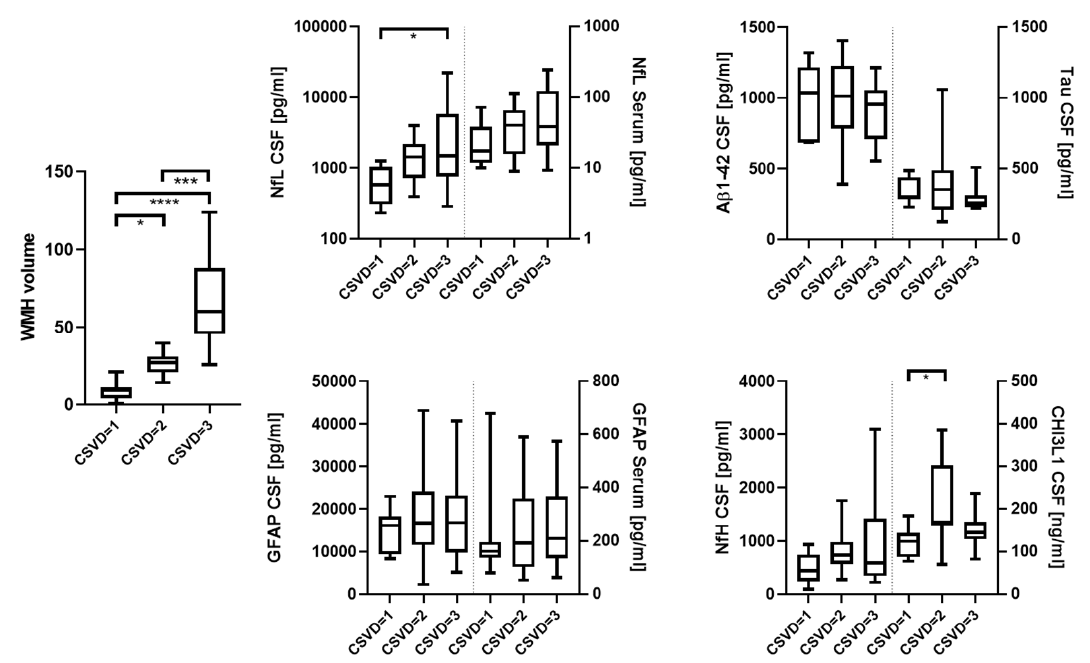
Figure 2. Degree of CSVD based on Fazekas (mild, moderate and severe) compared to WMH, NfL (CSF and serum), GFAP (CSF and serum), A β 1-42 (CSF), Tau (CSF), NfH (CSF) and CHI3L1 (CSF). * = p < 0.05; *** = p < 0.001; **** = p < 0.0001.